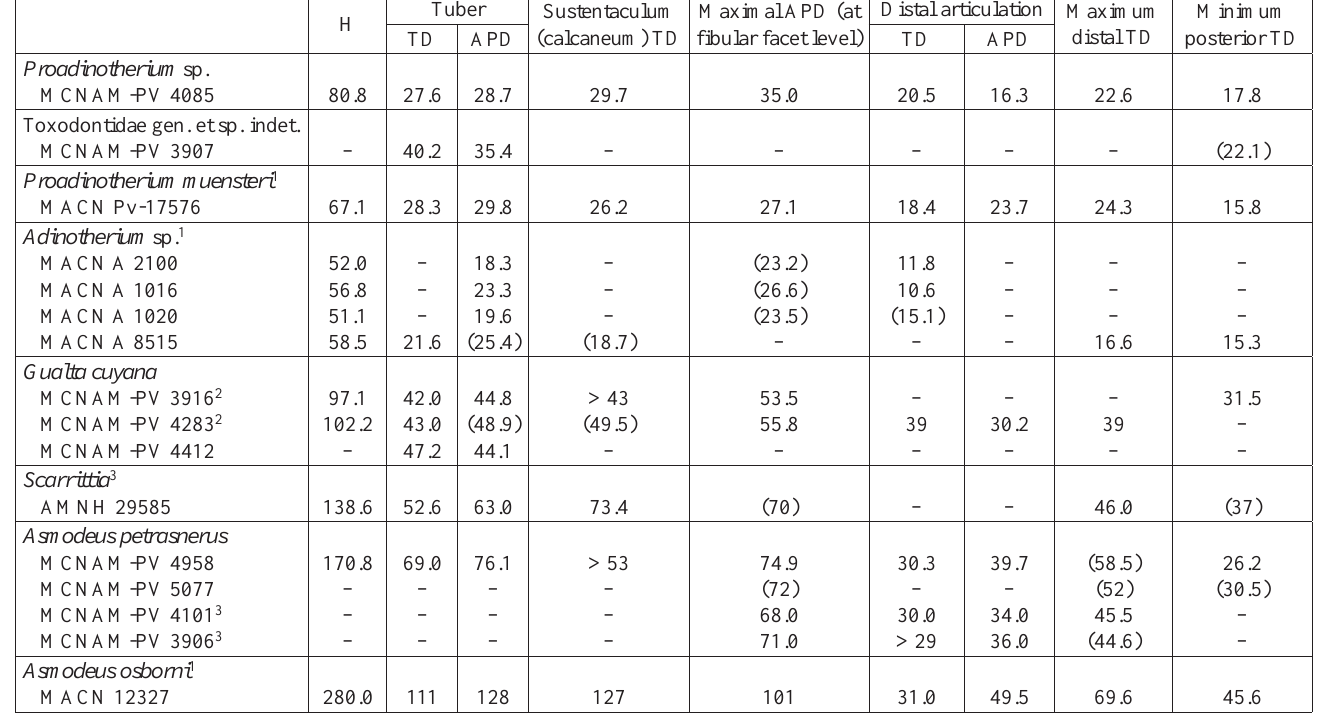
Table 1. Comparative dimensions (in mm) of the calcanei from Quebrada Fiera, Mendoza. 1 from photographs of specimens taken by SHP and FS; 2 after Cerdeño and Vera (2015); 3 completed after Seoane and Cerdeño (2014). Values in parentheses are approximate. APD, anteroposterior diameter; H, height; TD, transversal diameter; – measurement not available. H